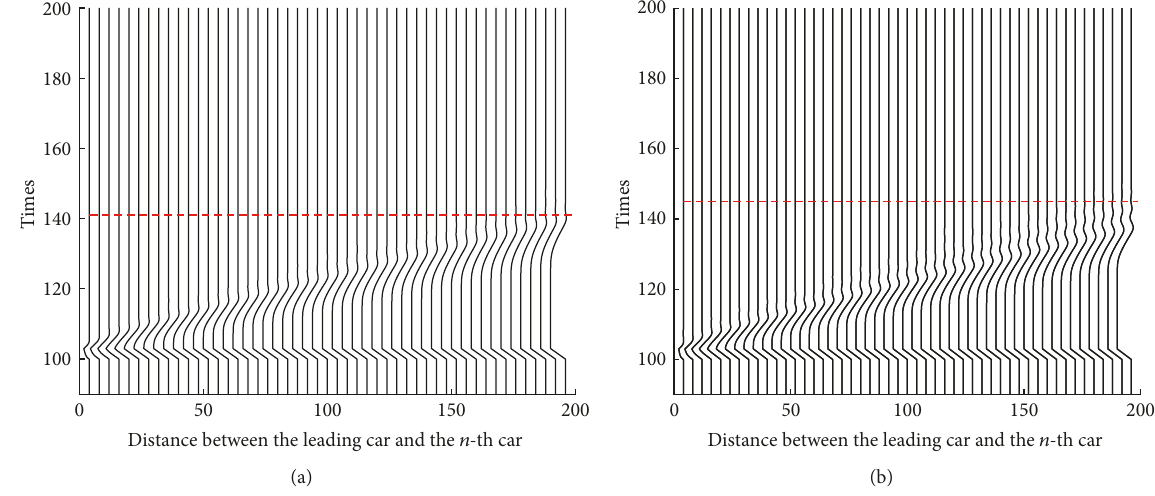
Figure 6: (Color online) distance-time profile of the LRVD model (a) and LVD model (b). The first car stops from 100 s to 103s with (a) LRVD model 𝜆 1 = 𝜆 2 = 𝜆 3 = 0.2 (b) 𝜆 3 = 0 , 𝜆 1 = 𝜆 2 = 0.2 . The red line shows the end of the distance change. The LRVD needs 141s, and LVD model needs 145